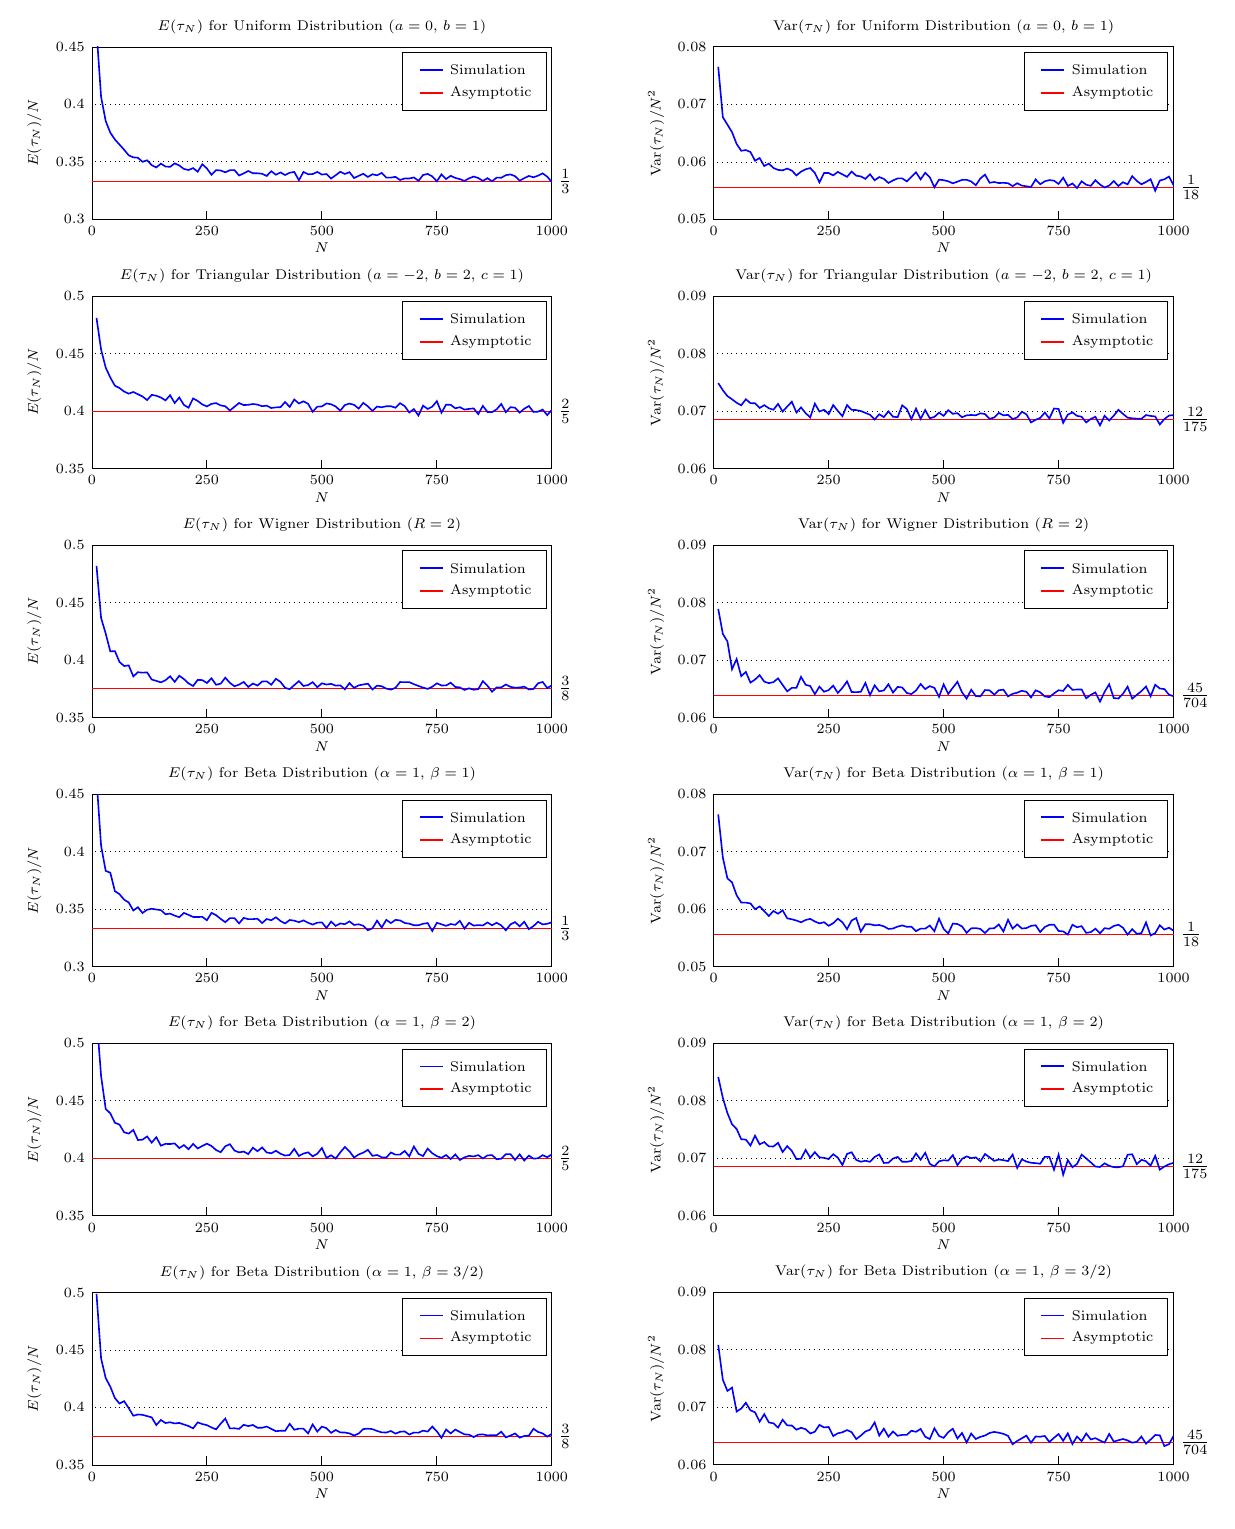
Figure 2. Comparison of large- N asymptotic predictions for the expectation and variance of the optimal stopping rule for a range of distributions on bounded domains. The asymptotic prediction is shown in red, while the simulated result is shown in blue. Each point on the simulated curve was obtained by simulating the optimal stopping problem 10,000 times, with the results used to estimate the expectation and variance of the optimal stopping point. We note that, for convenience of presentation, the expectation and variance were scaled by N and N 2 , respectively, so that the curves tended to a constant